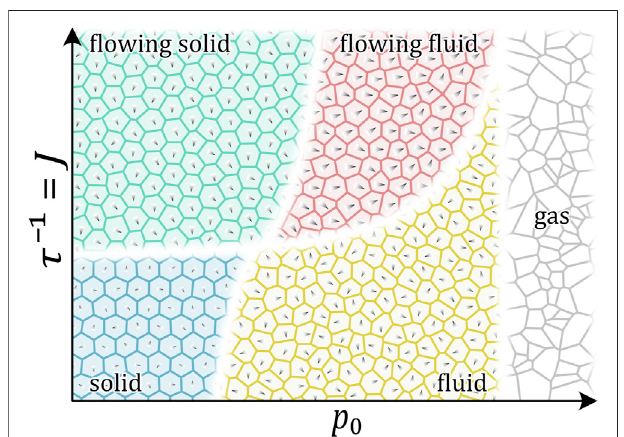
FIGURE 5 | Qualitative phase diagram of 2D cell monolayers at volume fraction close to 1. The phase diagram is based on [61, 75]. Control parametersarethetargetshapeindex p 0 andthealignmentinteraction J (cid:1) τ − 1 with τ being the reorientation time which is the time that cells take to adjust their polarities along the direction of the velocities of the corresponding local environments. The magnitude of the motility v 0 and its direction is indicated as arrows. Tissue approaches hexagonal-like structure for decreasing target shape factor. With increasing alignment interaction, the systemdisplaysmorelong-rangeddirectedmotility.Bluecellsinphasespace: alignment interactions are minor, and cellular reorientations are governed by rotational diffusion. The target shape index is small yielding roundish cells. Here, cells rarely align with neighborhood velocities and are randomly oriented. The energetically favored shape index is low-yielding hexagonal-like structures. Green cells in phase space: roundish cells and hexagonal-like tissue structures are present induced by a small target shape index. High- velocity correlations yield fl owing fl ocks of solid-like cell aggregates. Red cells in phase space: high-velocity correlations accompanied by elongated cells yield a fl uid phase in which aggregates undergo coordinated motion. Yellow cells in phase space: moderate to vanishing alignment interactions and elongated cells yield a fl uid phase where cells undergo predominantly random motion. Gray cells in phase space: cell interactions vanish in this phase due to the high target shape index. The cellular system behaves